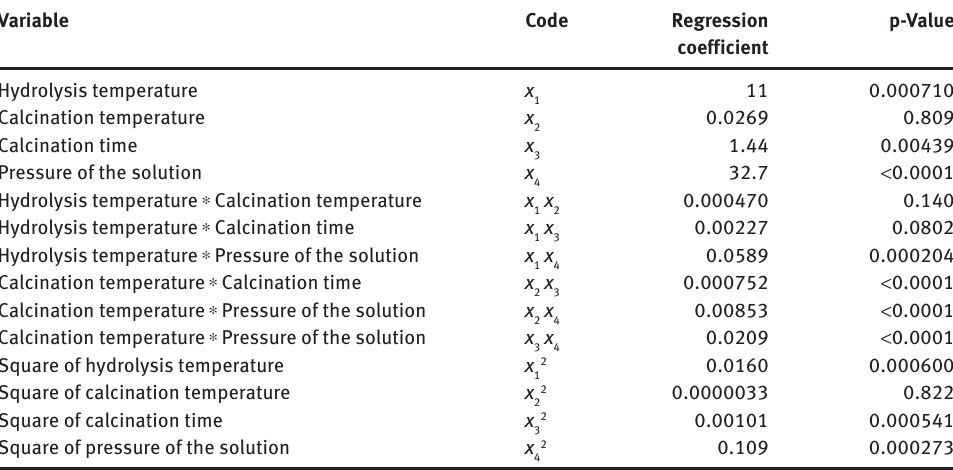
Table 3: Regression coefficient p-values of the response surface model.